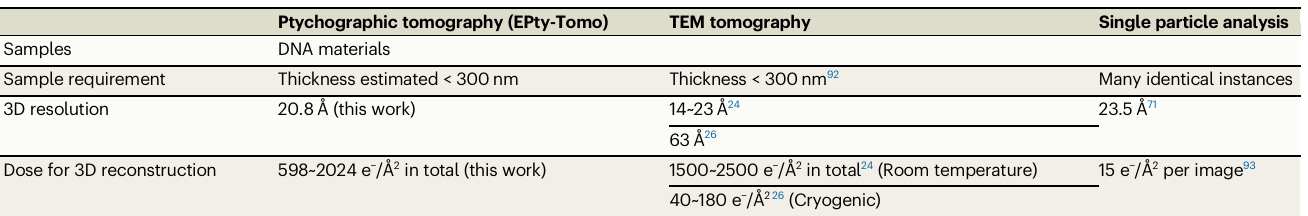
Table 1 | Current status of 3D TEM techniques applied to DNA origami characterisation